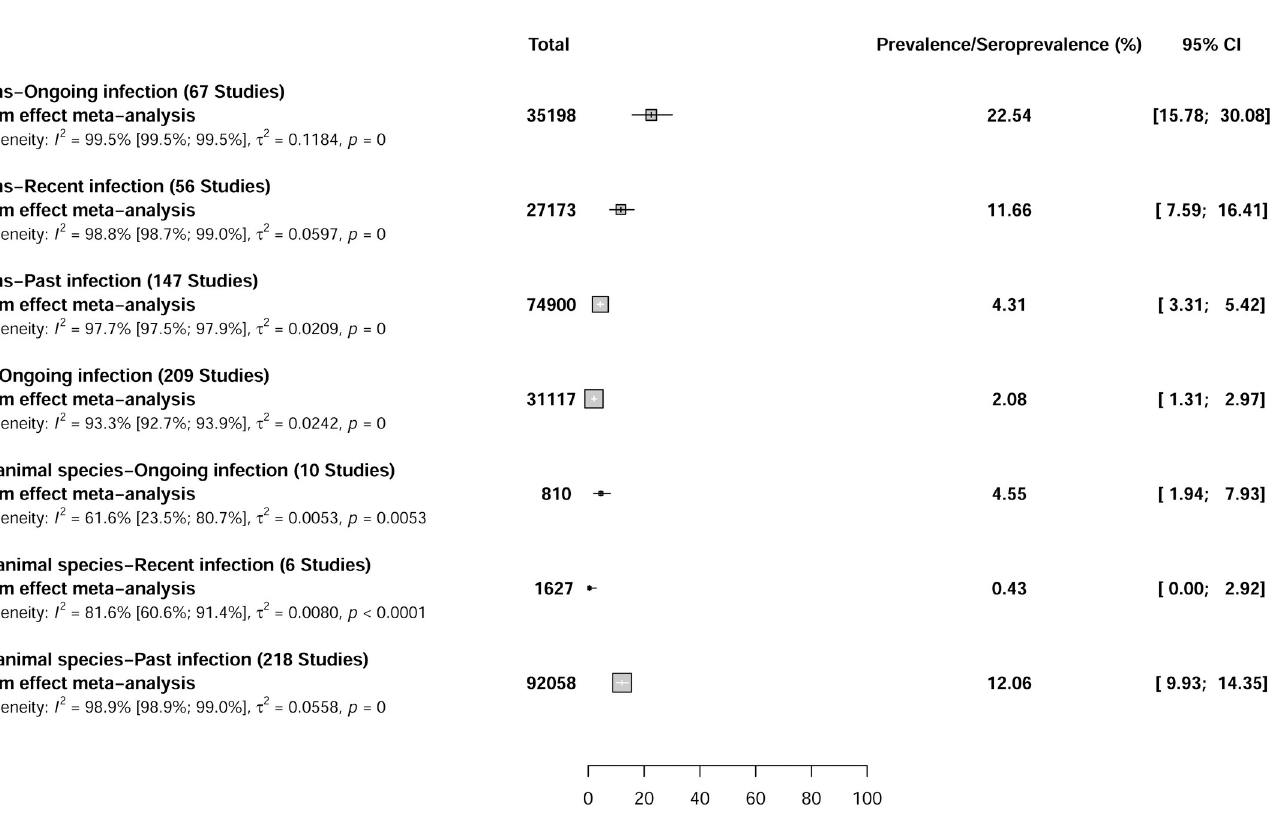
Fig 3. Global prevalence estimate of Crimean-Congo hemorrhagic fever virus infections in humans, ticks, and other animals species.